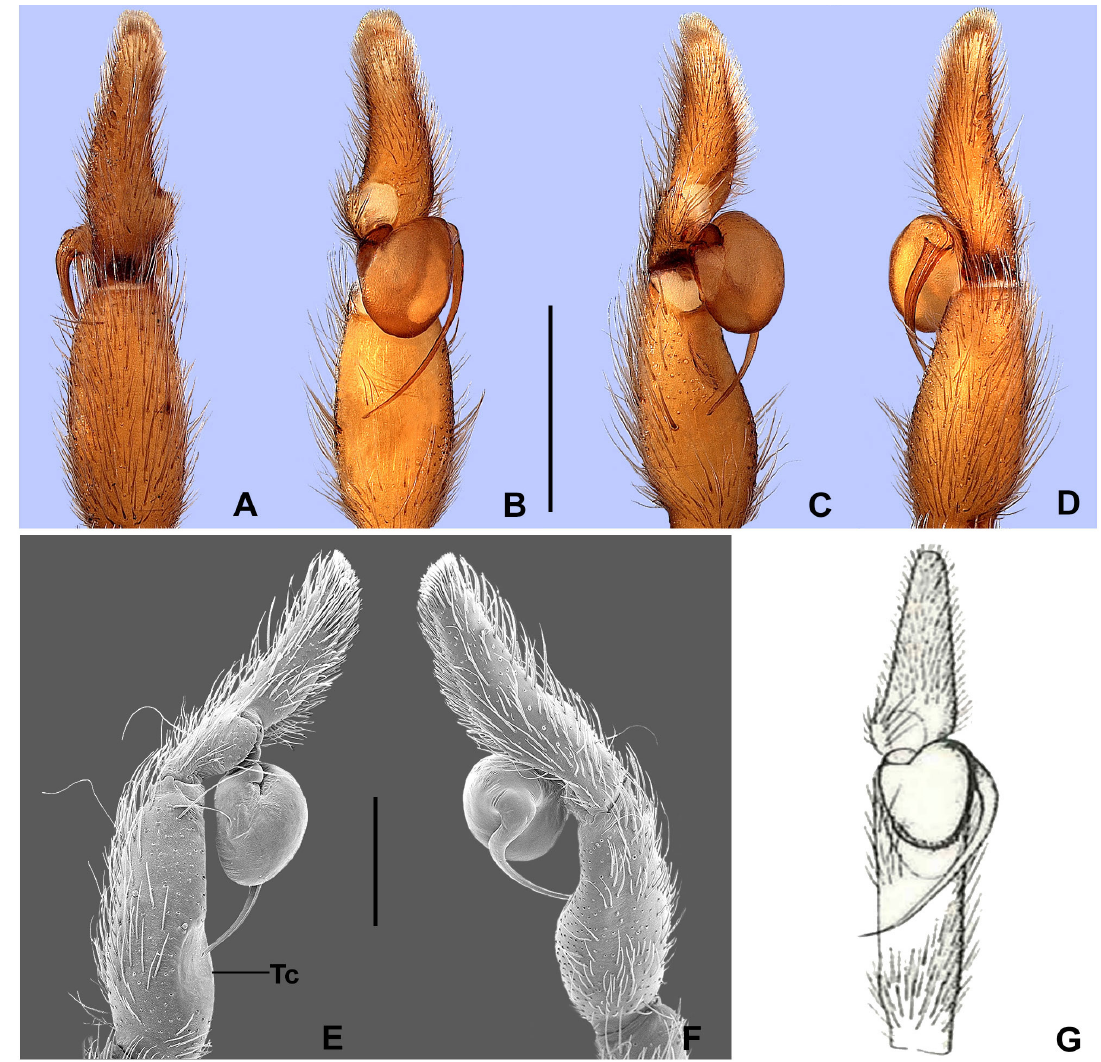
Fig. 2. Male palp of Ammonius pupulus Thorell, 1899. A–D . Holotype, ♂ (NHRS-GULI37848). A . Dorsal view. B . Ventral view. C . Prolateral view. D . Retrolateral view. E–F . SEM micrographs of the male palp of Ammonius pupulus (RMCA 227221). E . Prolateral view. F . Retrolateral view. G . Drawing from Benoit (1965: fig. 1), ventral view. Abbreviation: Tc = Tibial concavity. Scale bars: A–D = 1 mm; E–F = 0.5